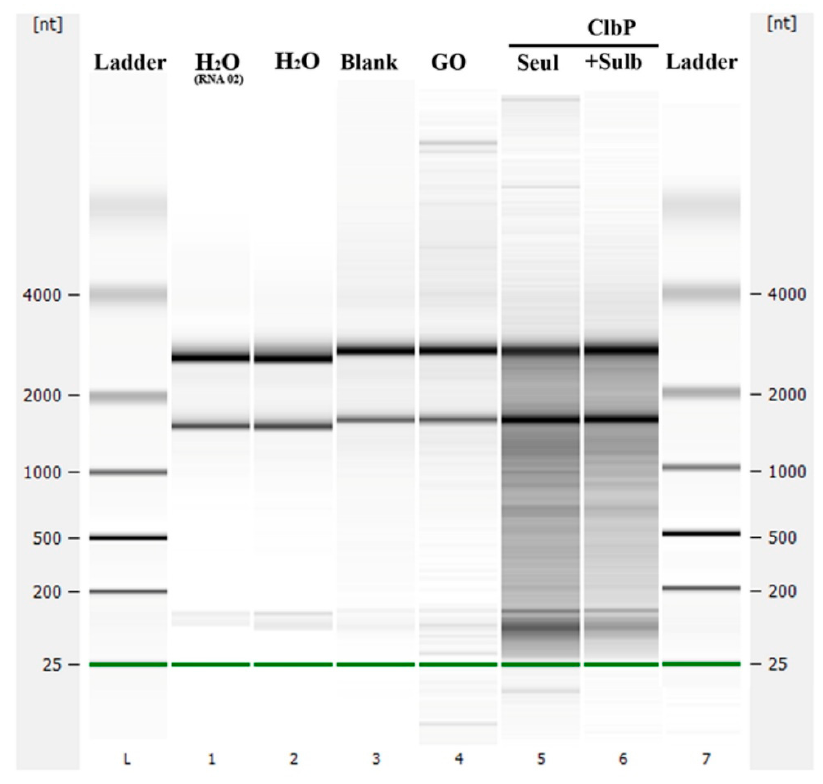
Figure 6. Test of the RNAse activity of the purified ClbP enzyme. GO (glycine oxidase) is used here as negative control enzyme.